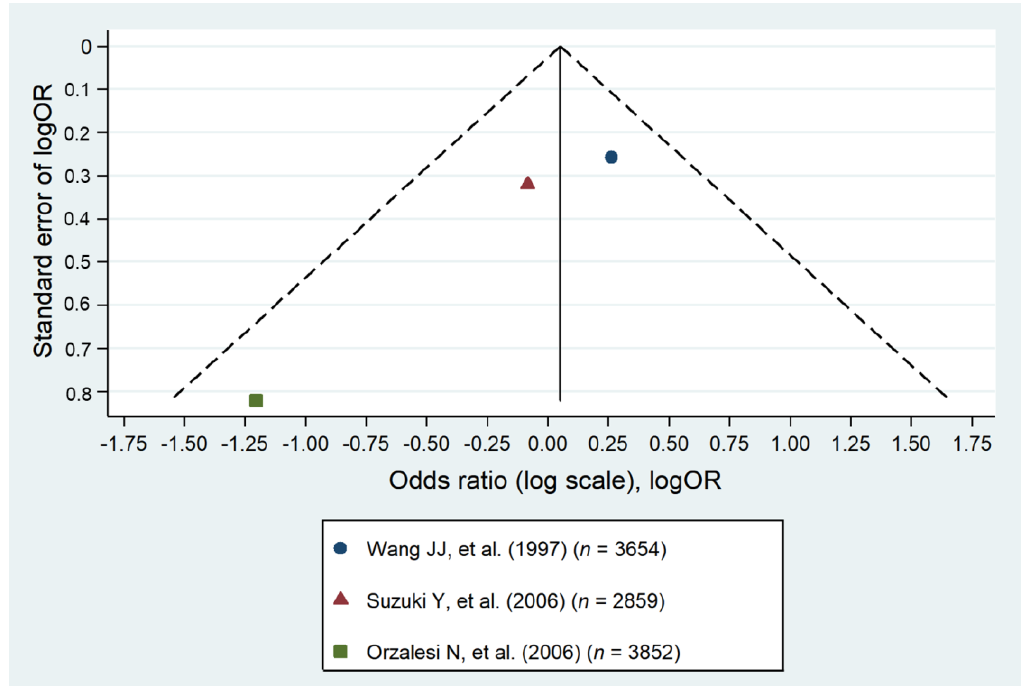
Figure 6. Forest plot of the cohort studies that evaluated migraine as a risk factor for the primary open angle glaucoma [11,31,49].